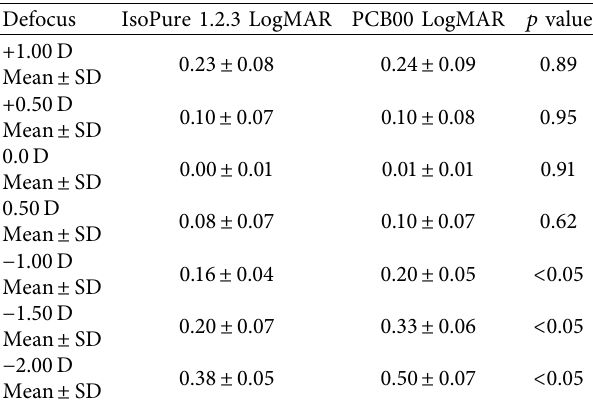
logMAR � logarithm of the minimum angle of resolution.